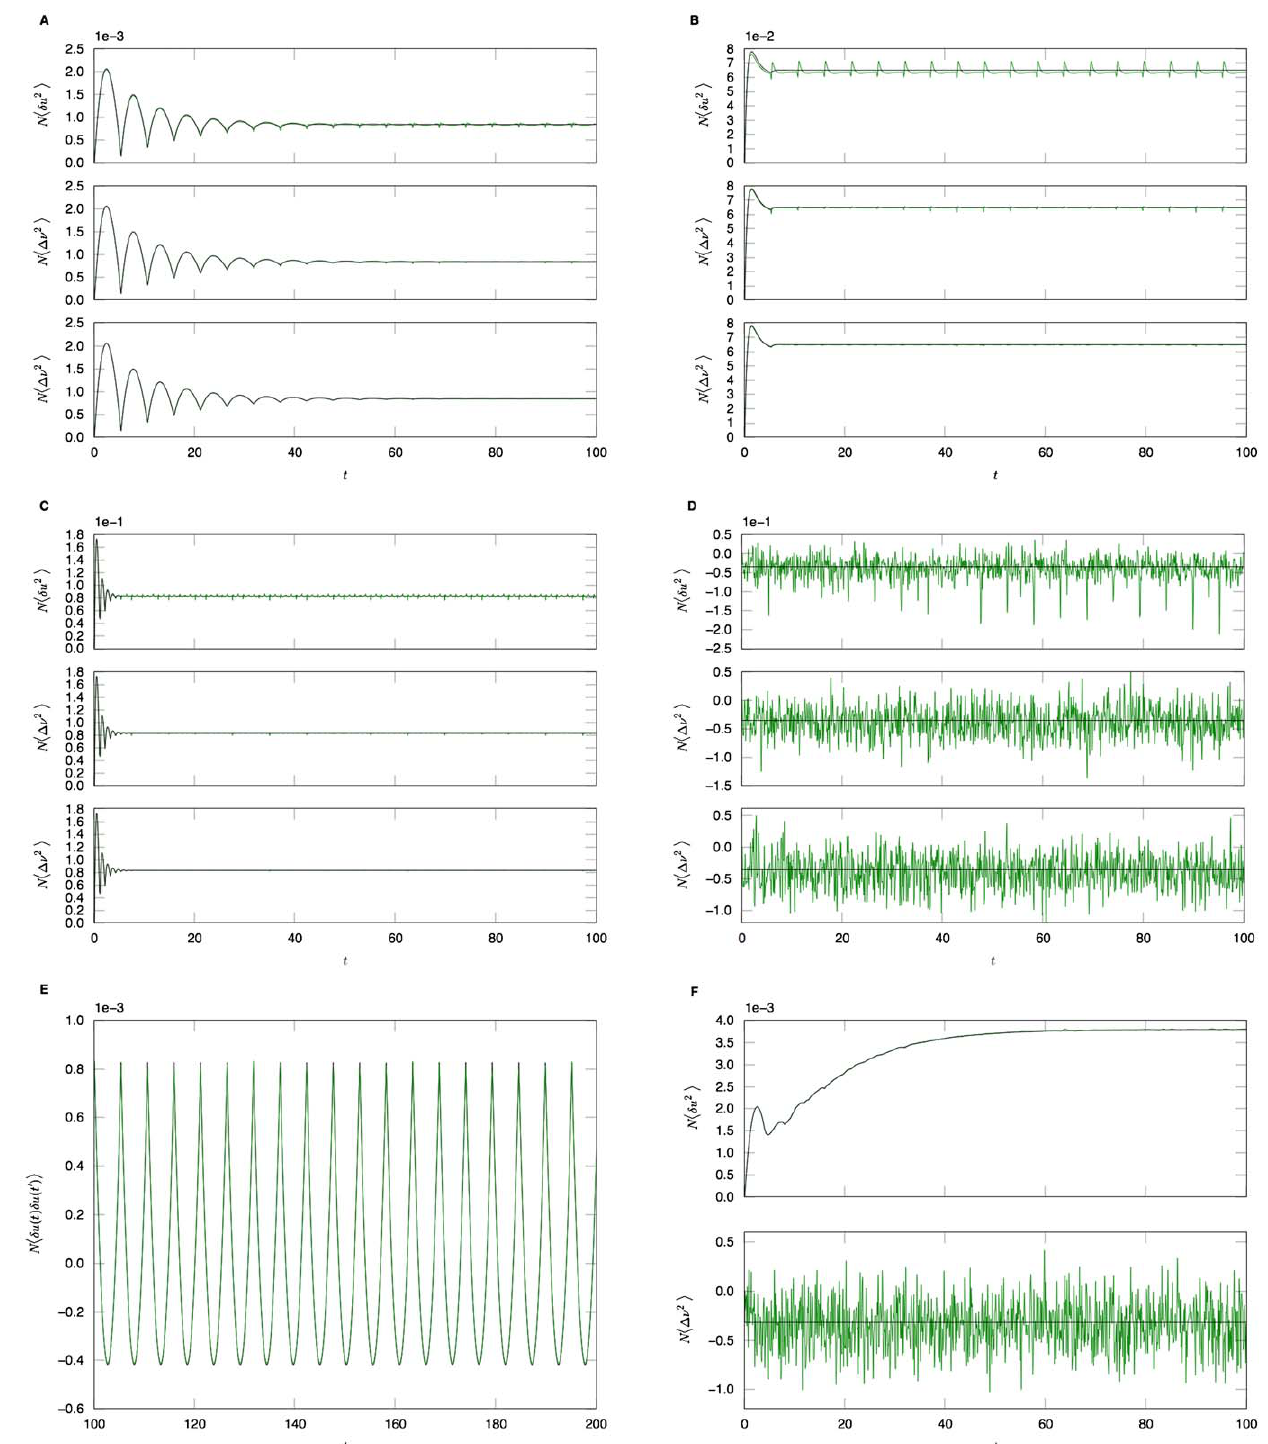
Figure 1. Phase model. A . Numerical computations (green line) and analytical predictions (black line) for N ~ 10 (top), N ~ 100 (middle), N ~ 1000 (bottom) of N S d u ( t ) 2 T for I ~ 1 : 0 , b ~ 0 : 1 , a ~ 1 : 0 . B . Numerical computations (green line) and analytical predictions (black line) for N ~ 10 (top), N ~ 100 (middle), N ~ 1000 (bottom) of N S d u ( t ) 2 T for I ~ 1 : 0 , b ~ 1 : 0 , a ~ 1 : 0 . C . Numerical computations (green line) and analytical predictions (black line) for N ~ 10 (top), N ~ 100 (middle), N ~ 1000 (bottom) of N S d u ( t ) 2 T for I ~ 5 : 0 , b ~ 1 : 0 , a ~ 1 : 0 . D . Numerical computations (green line) and analytical predictions (black line) for N ~ 10 (top), N ~ 100 (middle), N ~ 1000 (bottom) of N S D n ( t ) 2 T for I ~ 1 : 0 , b ~ 0 : 1 , a ~ 1 : 0 , where the ‘‘Poisson’’ contribution has been subtracted. E . Two-time correlator N S d u ( t ) d u ( t ’ ~ 100) T for I ~ 1 : 0 , b ~ 0 : 1 , a ~ 1 : 0 , and N ~ 100 . F . Equal time correlators in a heterogeneous network; N S d u ( t ) 2 T and N S D n 2 T for (cid:2) II ~ 1 : 0 , b ~ 0 : 1 , a ~ 1 : 0 and N ~ 100 . I is taken from the interval ½ 0 : 5,1 : 5) for each neuron. Ensemble averages for all simulations are taken over 1024000 samples. doi:10.1371/journal.pcbi.1002872.g001 PLOS Computational Biology |